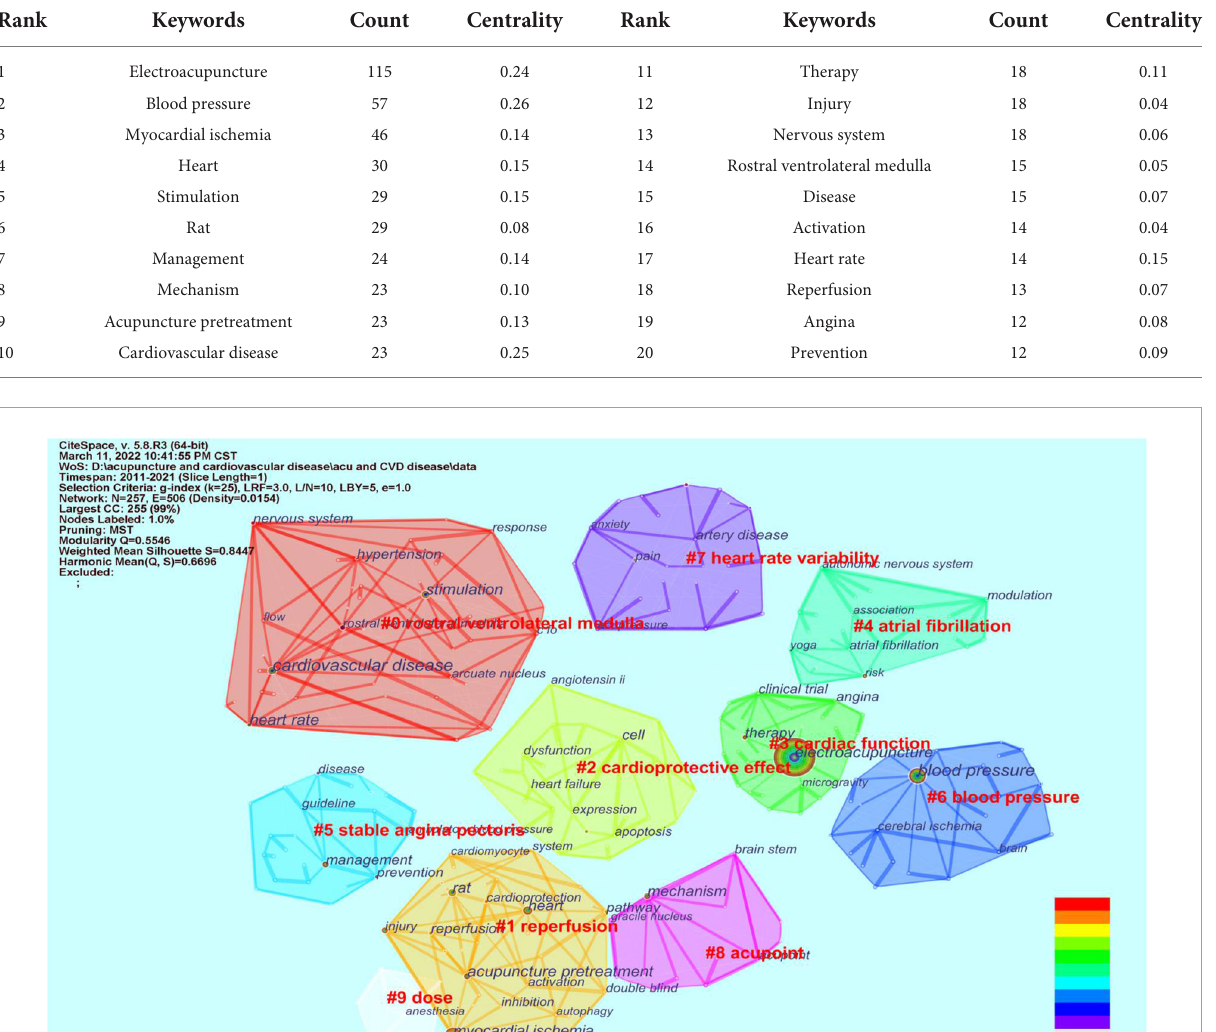
TABLE 6 The top 20 high-frequency keywords.